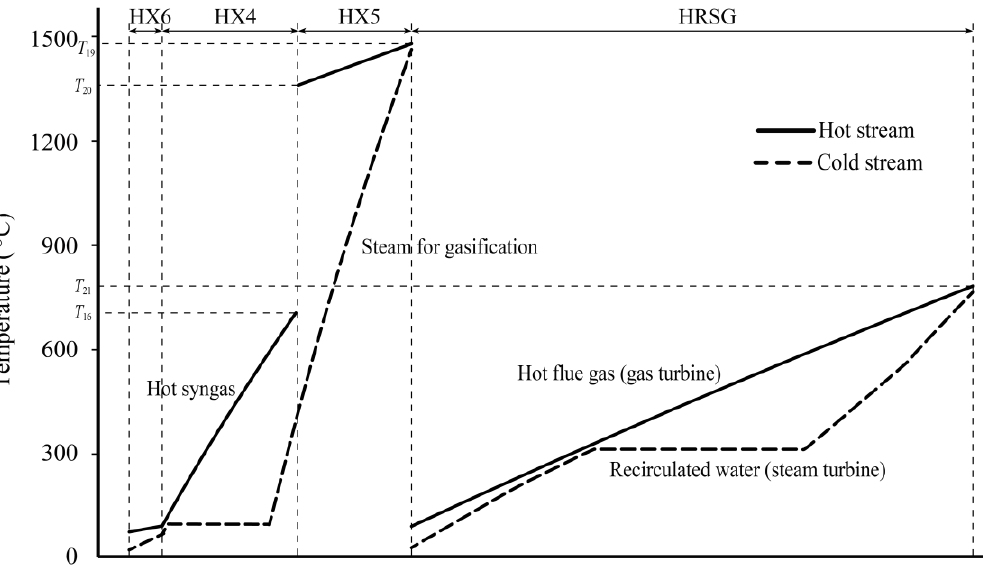
Figure 8. Temperature-enthalpy diagram for gasification and combined cycle modules in the integrated processes (fluidization velocity of 4 U mf